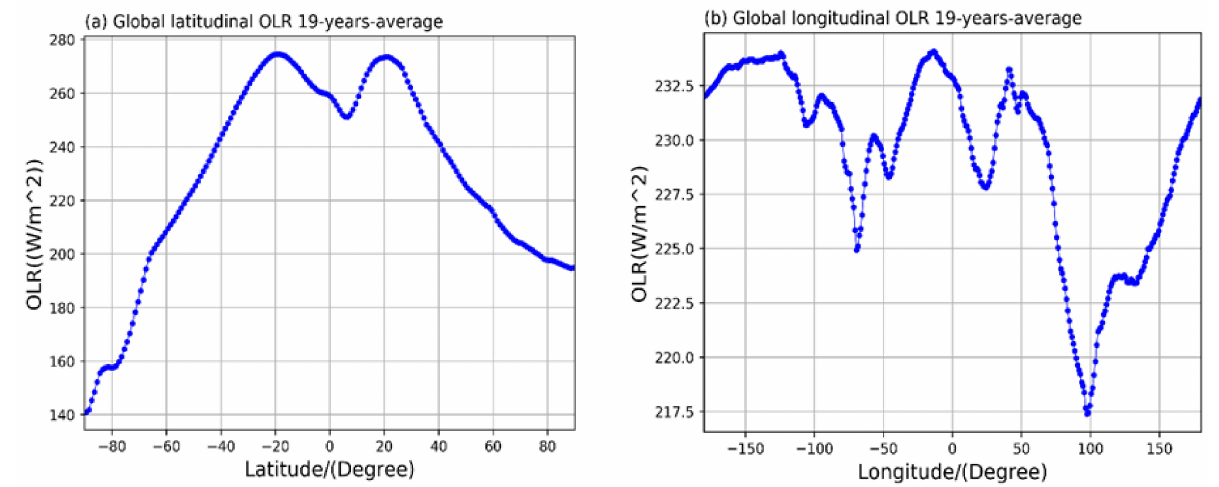
Figure 2. Inter-annual variability trend of latitude and longitude of OLR. ( a ) Latitudinal variation. ( b ) Longitudinal variation.